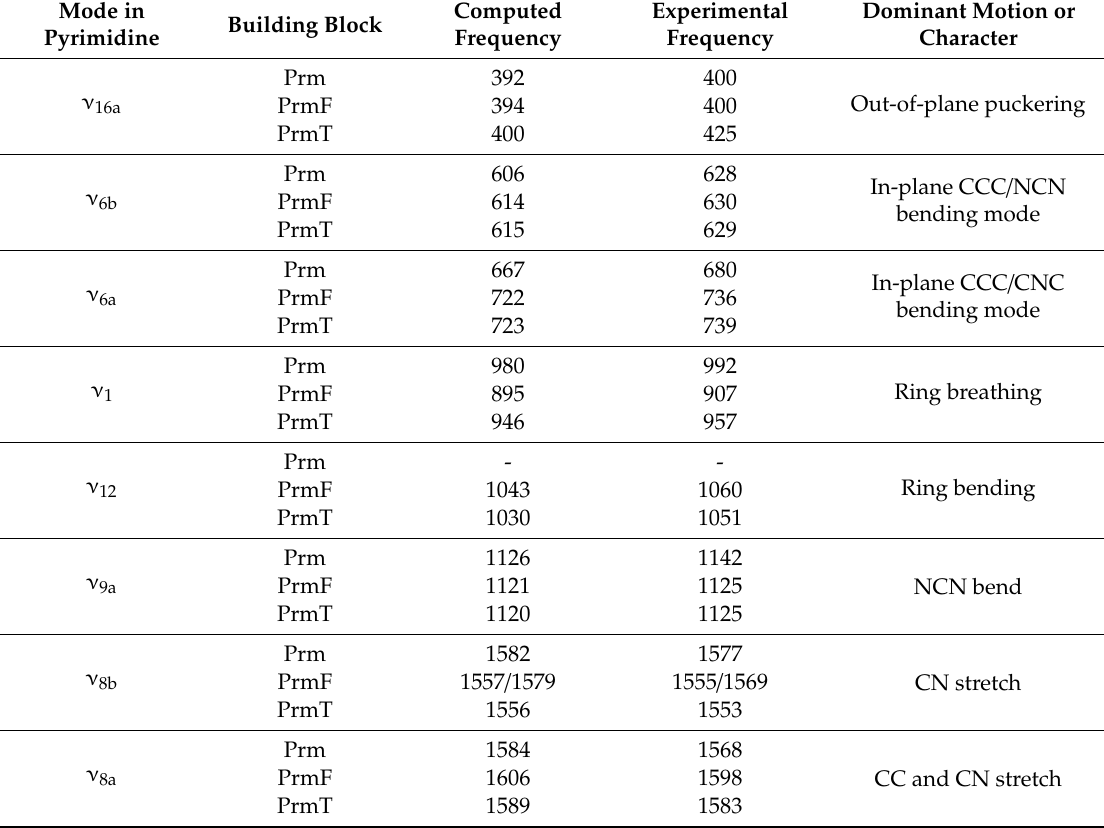
Table 2. Assignment of normal modes in Prm derivatives PrmF and PrmT, and analysis of the degree of coupling with other modes. Frequencies are in cm –1 , and computed values have been scaled by 0.956 to account for